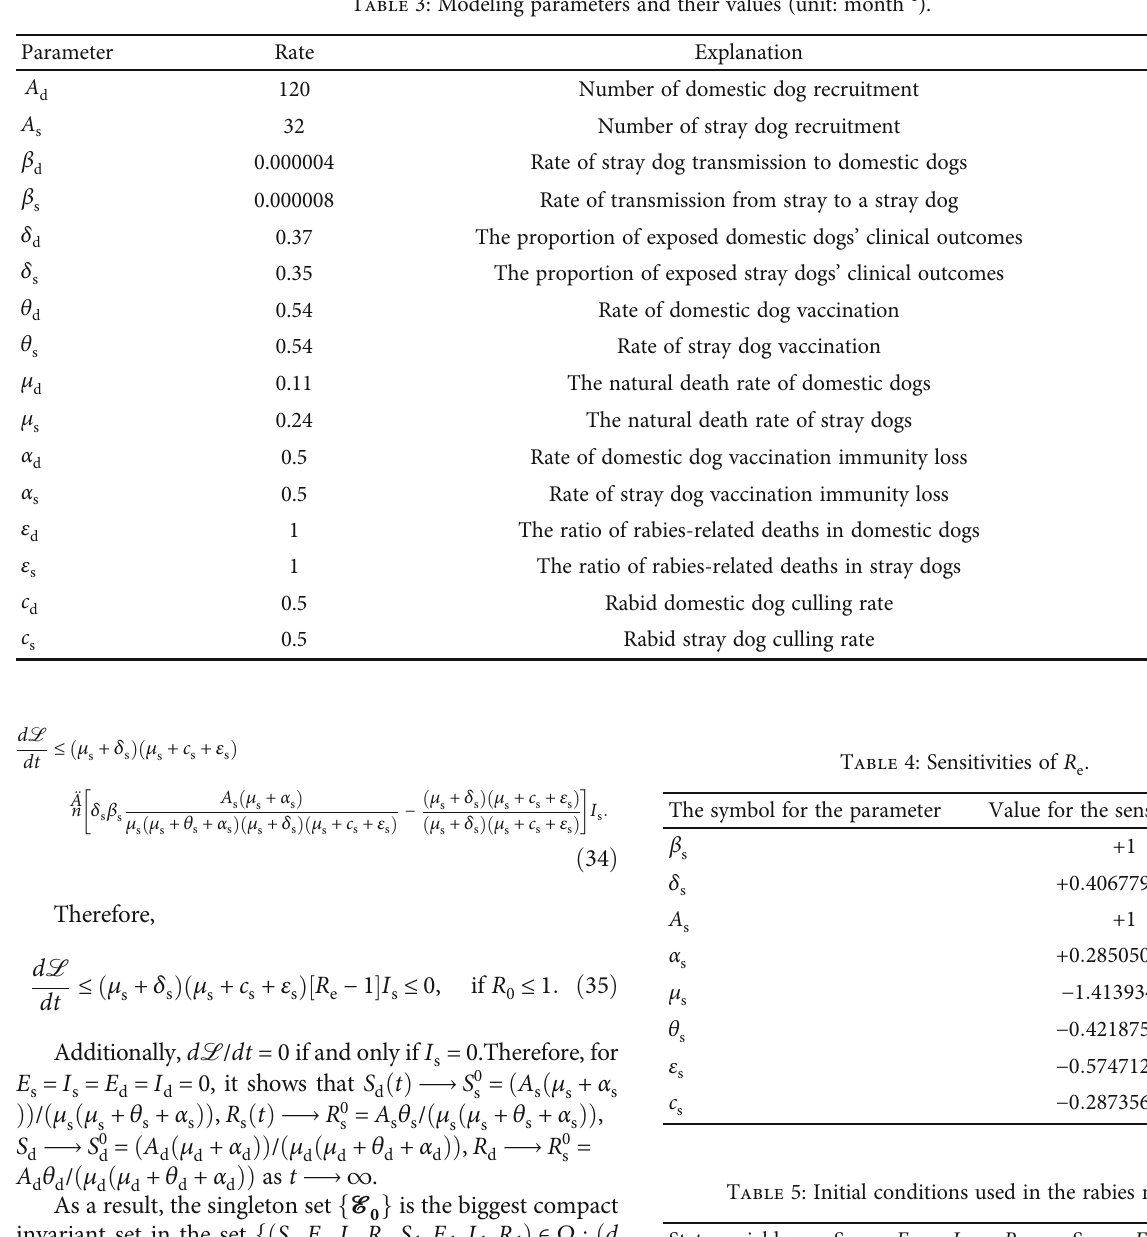
Table 3: Modeling parameters and their values (unit: month -1